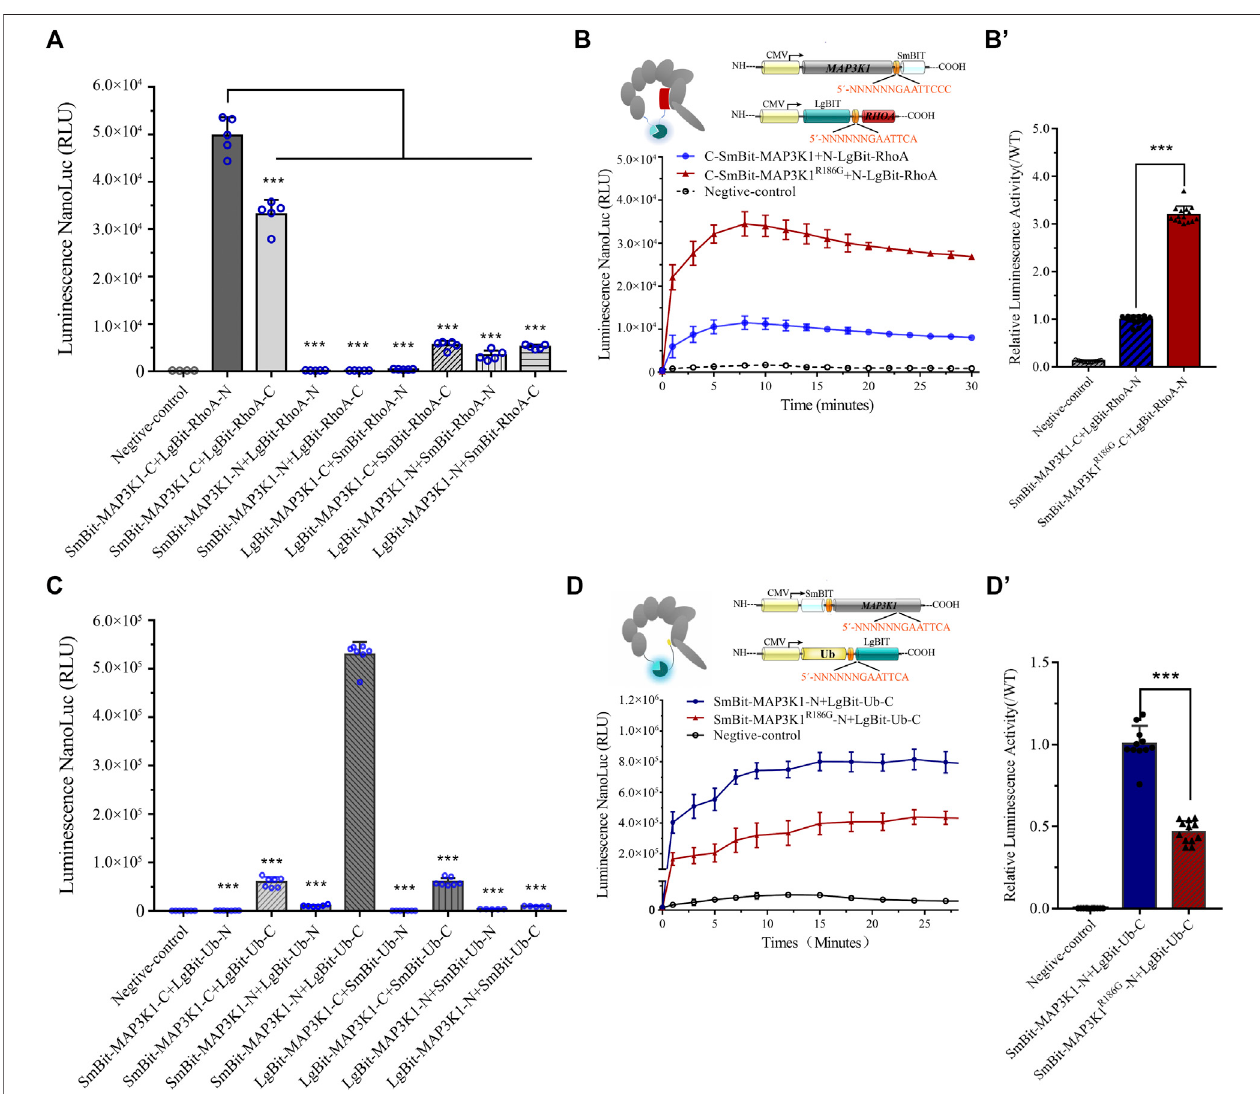
FIGURE 4 | Changed interaction between MAP3K1 and RhoA or Ub. (A,B) The capacity of wild-type (MAP3K1) and variant (MAP3K1 R186G ) of MAP3K1 to bind RhoA. (A) LgBiT and SmBiT fusion expression vectors with MAP3K1 and RHOA gene were established and instantaneously transfected into HEK293T cells with 8 different combinations. The combination of maximum response signals was fi ltered. Each dot in the graphs represents a single repetition ( n = 5; mean ± SEM shown; *** p < 0.001by t -test). (B) SchematicstructureofMAP3K1andRhoANanoBiT-fusedproteins.The MAP3K1 geneandtheC-terminusofSmBiTwerefusedtoform the MAP3K1 -SmBiT-C plasmid. The RHOA gene and the N-terminus of LgBiT were fused to form the RHOA -LgBiT-N expression plasmid. Negative control was transfected with only the MAP3K1 -SmBiT-C plasmid. Twenty-4 hours after co-transfection, the diluted substrate was directly added to each well to measure the absolute value of NanoBiT activity for 30 min. (B) For comparison, the mean wild-type values at each time point were adjusted to 1 ′ , and each black triangle represents the relative value of MAP3K1-RhoA binding capacity in the mutant group at the corresponding time point. HEK293T cells transfected with only Smbit-MAP3K1-C plasmid used as a negative control. (C,D) The ability of wild-type (MAP3K1) and variant (MAP3K1 R186G ) of MAP3K1 to bind Ub. (C) LgBiT and SmBiT fusion expression vectors with MAP3K1 and UB genes were determined and instantaneously transfected into HEK293T cells with 8 different combinations. Each dot in the graphs represents a single repetition. (D) Schematic structure of the MAP3K1 and Ub NanoBiT-fused proteins. The MAP3K1 gene and the N-terminus of SmBiT were fused to form the SmBiT- MAP3K1 -N plasmid. The UB gene and the C-terminus of the LgBiT were fused to form the UB -LgBiT-C expression plasmid. Negative control was transfected with the SmBiT- MAP3K1 -N plasmid only. Twenty-4 hours after co-transfection the absolute value of NanoBiT activity for 30 min was measured ( n = 7; mean±SEMshown;*** p < 0.001by t -test). (D 9 ) Themeanwild-typevaluesateachtimepointwereadjustedto1 ′ ,andeachblacktrianglerepresentstherelativevalueof MAP3K1-Ub binding capacity in the mutant group at the corresponding time point. HEK293T cells transfected with only Smbit-MAP3K1-N plasmid were used as a negative control. Each value represents the mean ± SD from at least three independent cultures (*** p < 0.001 by t